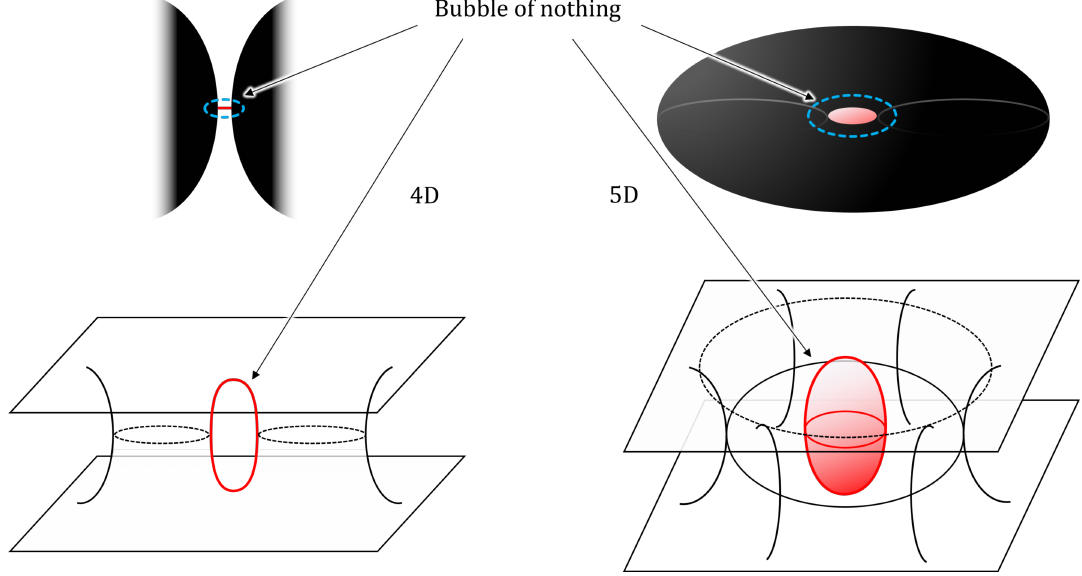
Figure 1 . Bubbles of nothing as limits of black hole systems. The top pictures are illustrative cartoons, and the bottom ones show time-symmetric spatial sections of the maximally extended solutions. Left top: the 4D bubble of nothing arises as the geometry in between two black holes, in the limit when their size is very large. The horizons of the black holes correspond to acceleration horizons of the bubble. Left bottom: the bubble is a minimal circle (in red) linking the Einstein- Rosen throats of the two black holes. This circle encloses ‘nothing’, and its expansion occurs as the throats stretch in the black hole interiors. The angle φ around the rotation axis is suppressed in these figures. Right top: the 5D bubble is similarly recovered from the central region of a very fat black ring. Right bottom: the bubble is a sphere (in red) that wraps the portion of the Einstein-Rosen bridge in the inner ‘hole’ of the ring. In the bottom figure, the ring’s S 2 is not represented. In the solutions we discuss, the black hole binary and the black ring are kept static by semi-infinite cosmic strings and cosmic membranes (not shown), respectively, which pull them outwards, but other means of maintaining them in equilibrium are